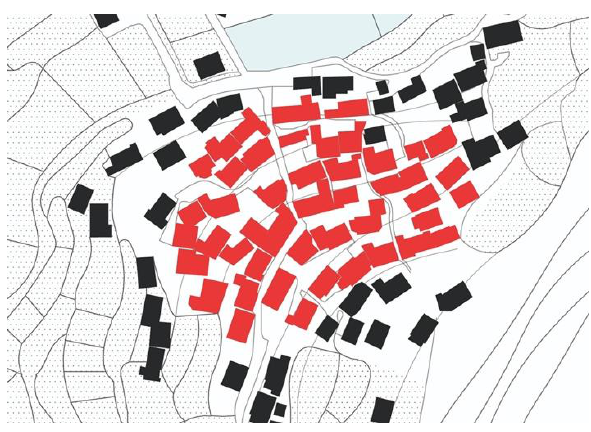
Figure 9. Group Stitching.